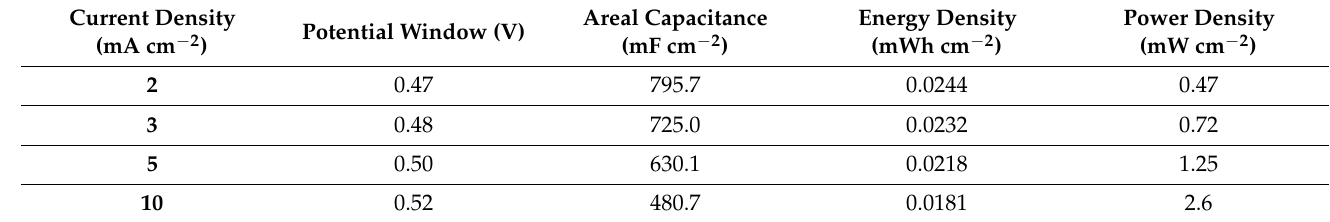
Table 2. Comparative table of areal capacitance, energy density, and power density of MFS-15 electrode calculated at different current densities along with potential window.